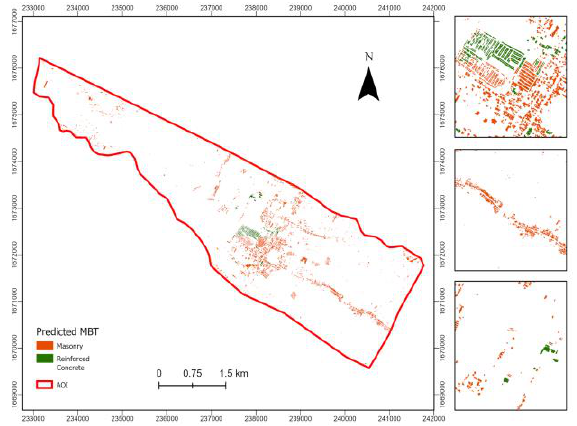
Figure 8. Predicted MBTs in the study area using RF